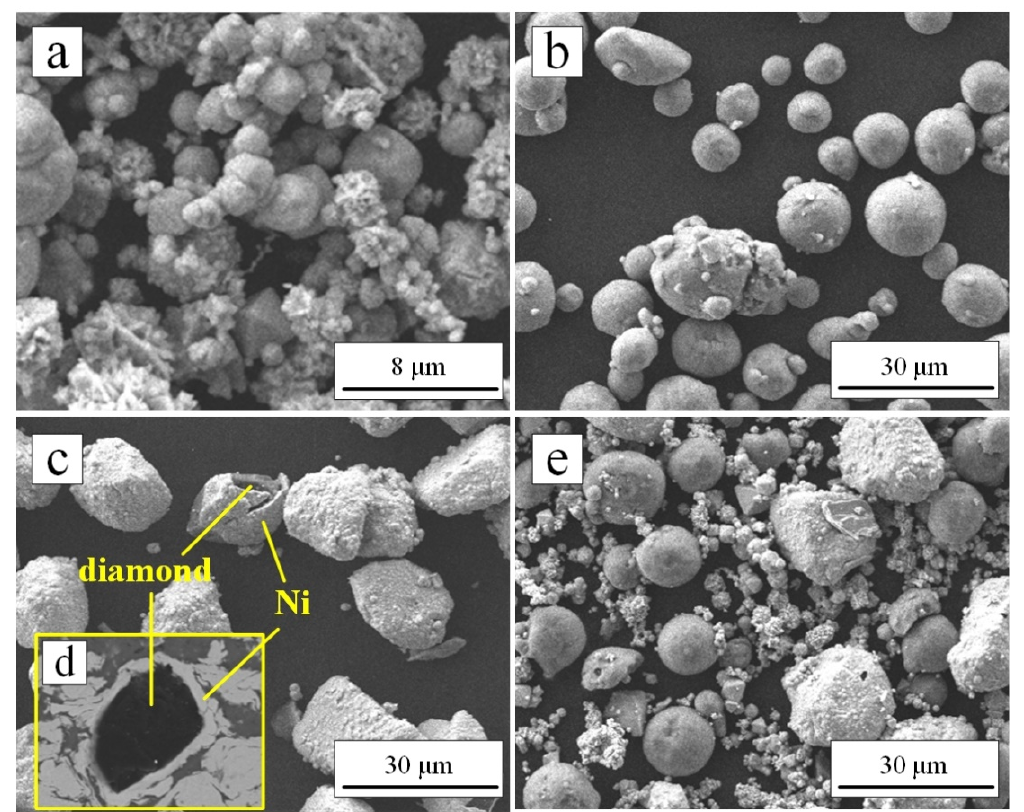
Figure 2. Morphology of the feedstock powders used in this study: ( a ) Ni, ( b ) Al, ( c ) diamond, ( d ) the core–shell structure of Ni-coated diamond and ( e ) the mixed powders.